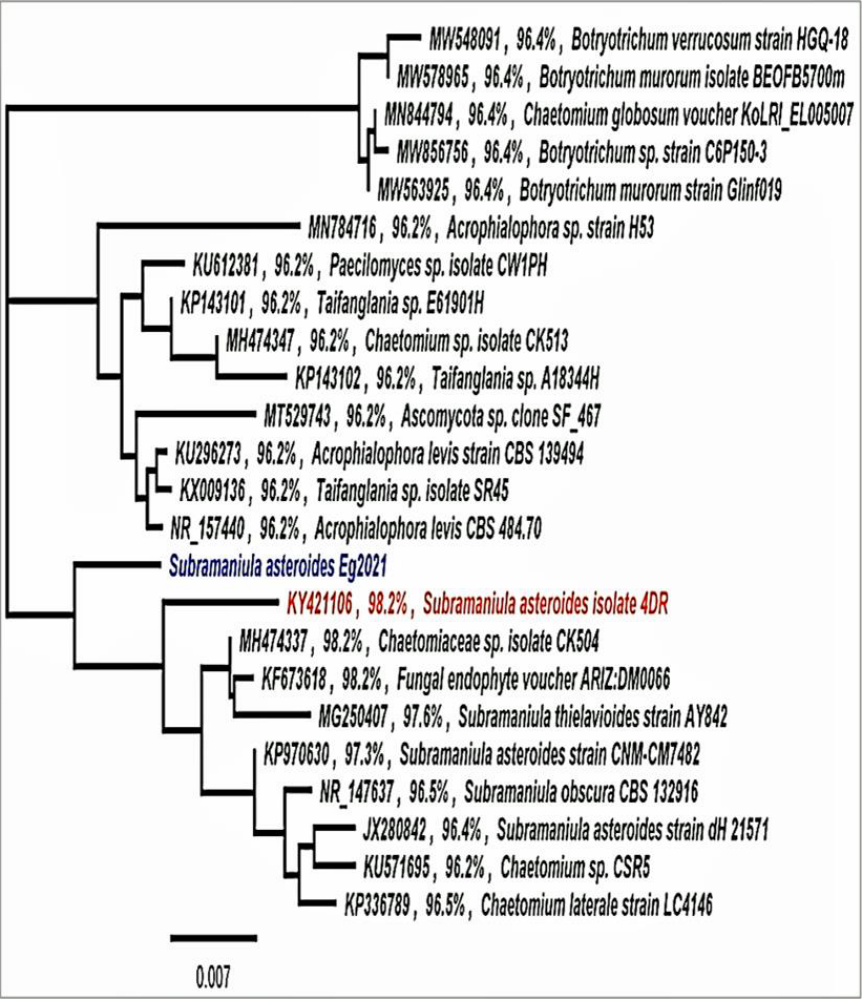
Figure 3. The molecular characterization of Subramaniula asteroids . The phylogenetic tree was drawn by Geneious pro program using maximum likelihood methods.